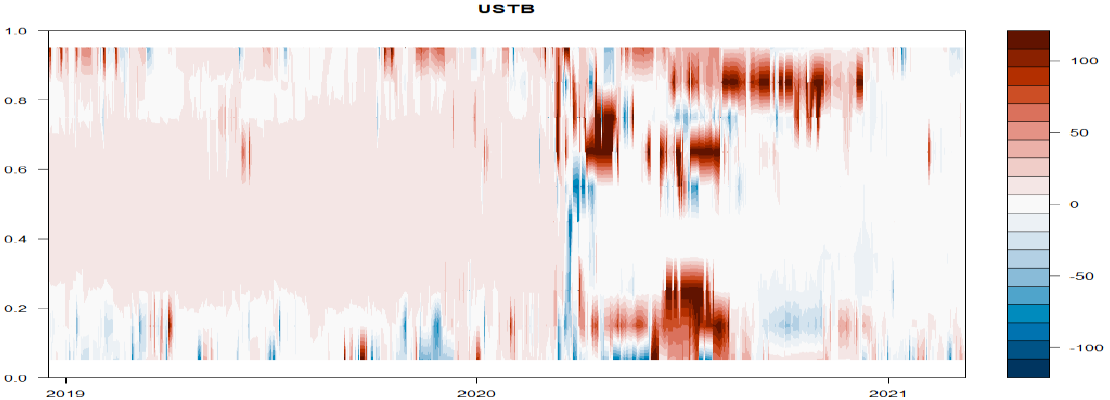
Figure 4. Results for net total directional connectedness for the S&P Green Bond Index based on a 200-day rolling-window QVAR(1) and a 20-step-ahead forecast.